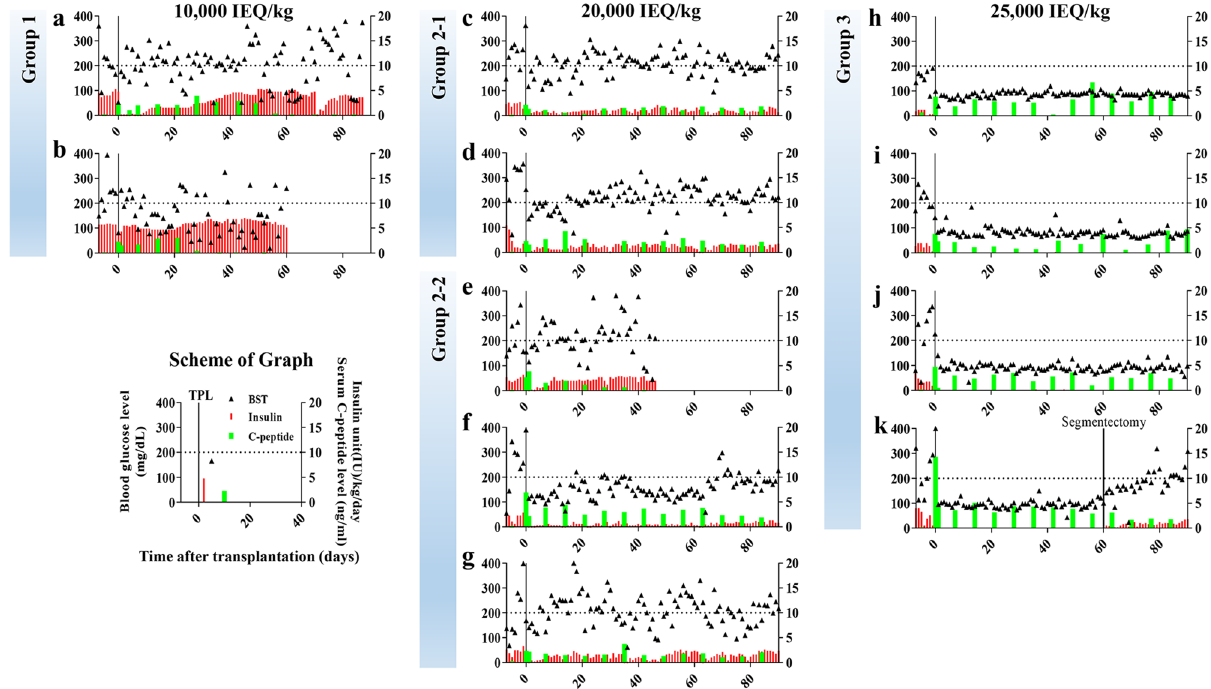
Figure 2. Blood glucose level control depended on the transplanted islet dose. After allogeneic islet transplantation, the blood glucose, C-peptide, and exogenous insulin administration levels of eleven monkeys were monitored for up to 90 days. ( a , b ) The group 1 monkeys received 10,000 IEQ/kg and showed uncontrolled blood glucose levels despite being given the most exogenous insulin. Monkeys A and B were terminated 87 and 60 days after transplantation, respectively, according to our experimental criteria. ( c – g ) The group 2-1 and 2-2 (induction as ATG + RTX) monkeys received 20,000 IEQ/kg and maintained blood glucose levels near 200 mg/ dL through the provision of high levels of exogenous insulin. Monkey E expired unexpectedly but without significant changes in the relevant biological parameters. ( h – k ) The group 3 monkeys received > 25,000 IEQ/ kg and achieved normal blood glucose levels with ( i , j ) or without ( h , k ) receiving exogenous insulin. The serum C-peptide level increased as the transplanted islet dose increased. ( k ) The blood glucose, C-peptide levels, and exogenous insulin requirements of Monkey K, who underwent a segment 2 segmentectomy 2 months after transplantation. Monkey K regressed to levels similar to those in group 2 and required daily exogenous insulin to maintain an appropriate blood glucose level.